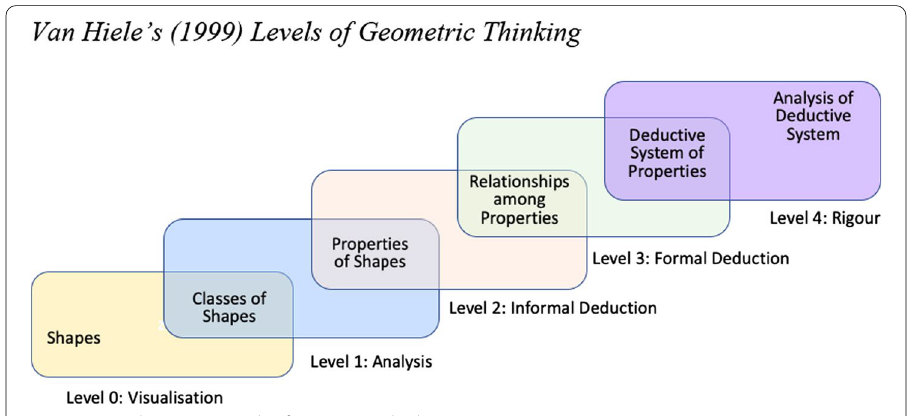
Fig. 1 Van Hiele’s (1999) Levels of Geometric